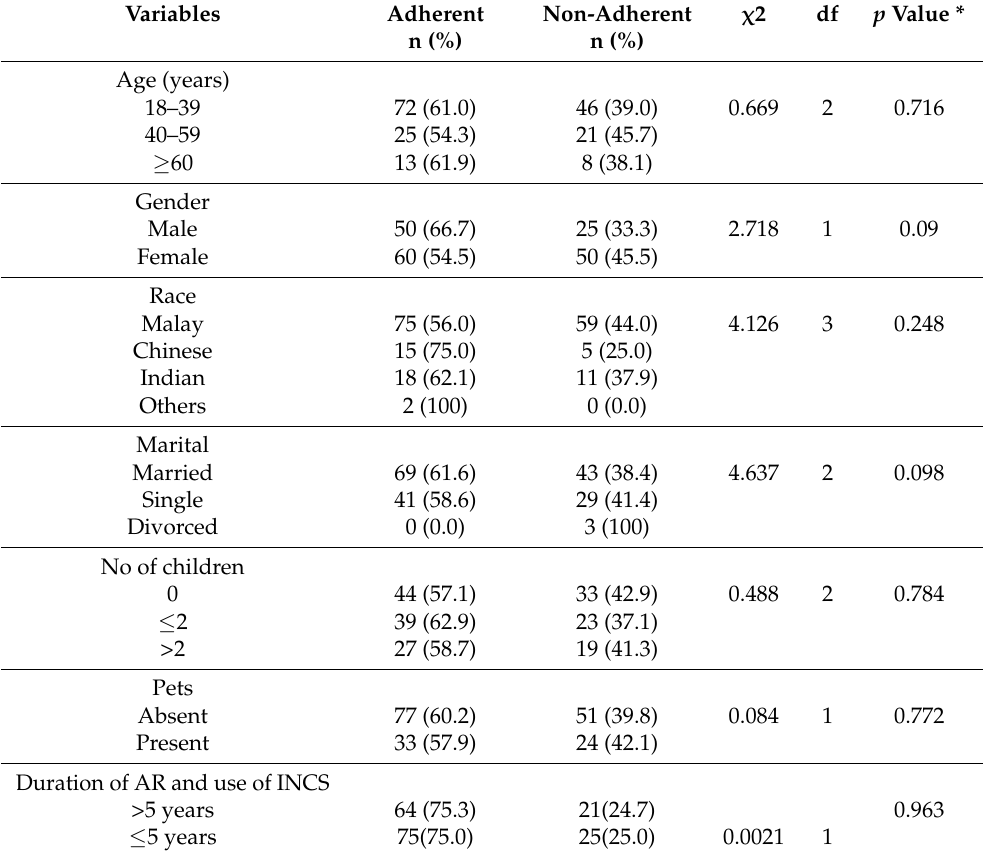
Table 1. The characteristics of participants.